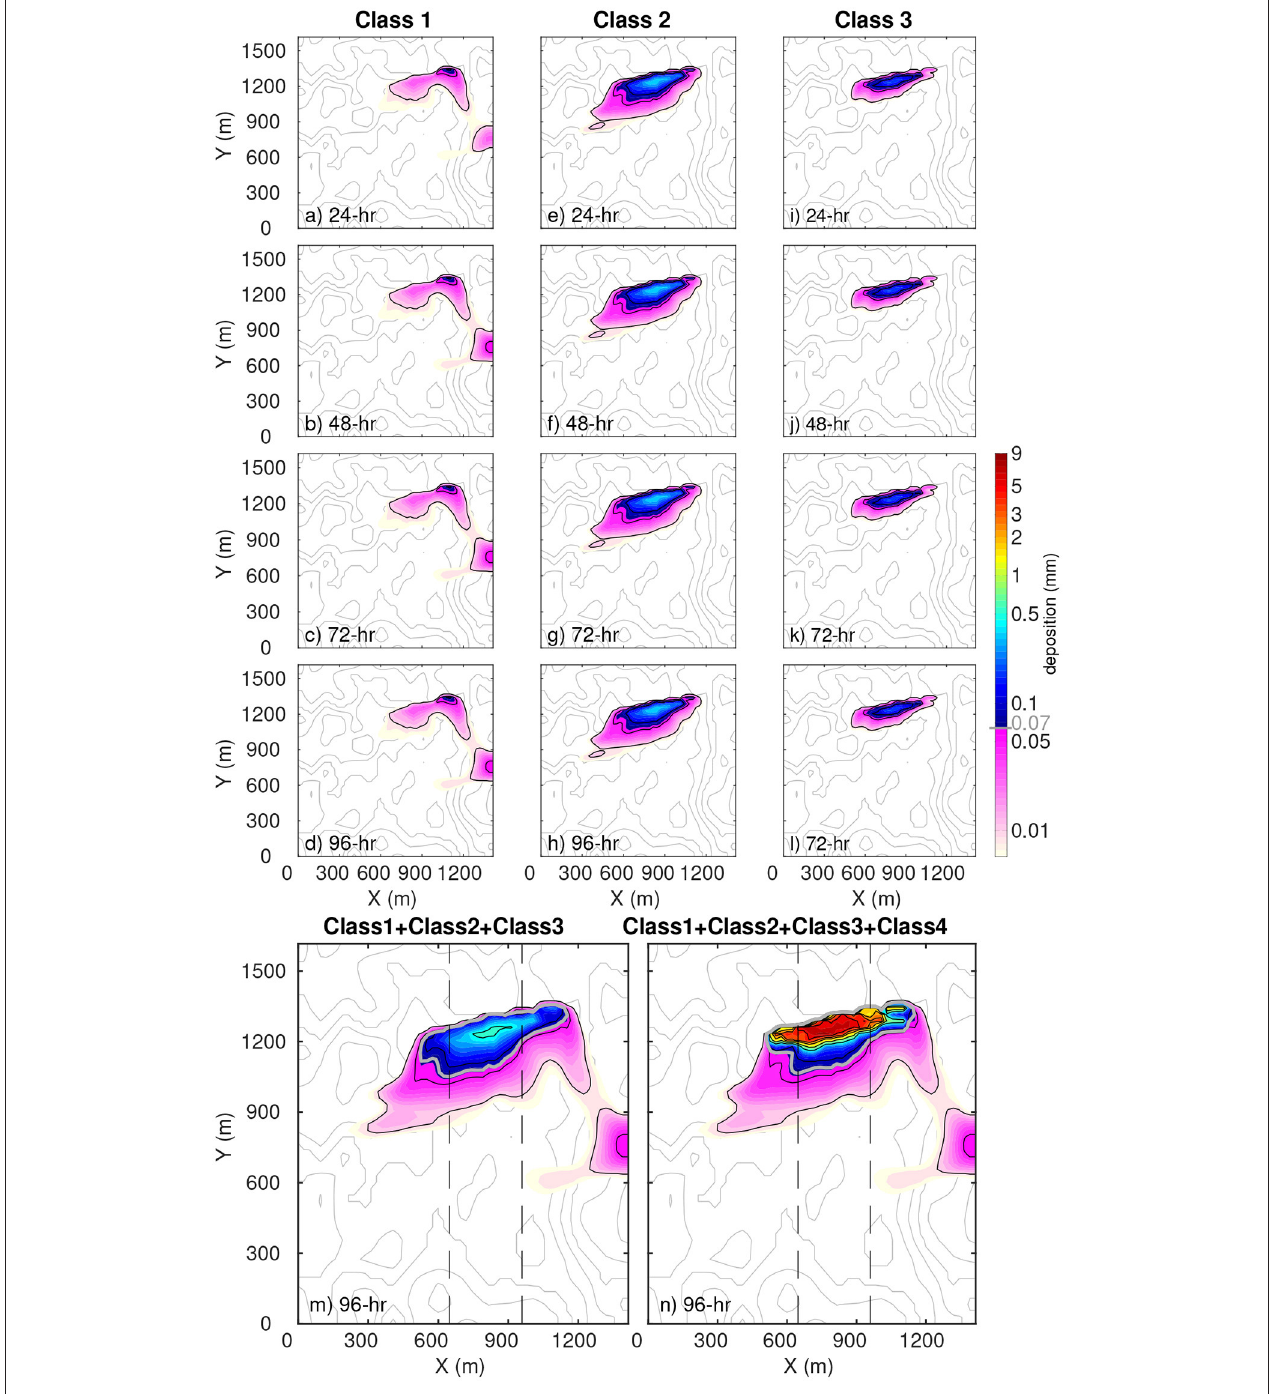
FIGURE 7 | Sediment redeposition patterns at (a) 24 h, (b) 48 h, (c) 72 h, and (d) 96 h after dredging for particle size class1. Subplots (e–l) show similar for particle size class 2 and class 3, respectively. The colourbar indicates the thickness of sediment redeposition from 0.01 to 9 mm in logarithmic scale. Black solid contours refer to labels at the colourbar axis. Total accumulation of sediment deposition is shown in (m) for class 1–3 and in (n) for class 1–4. The 0.07 mm deposition thickness shown as thick grey contours marks the boundary between near- and far-field areas. The dashed lines show the position of transects X1 and X2 in Figure 11 .